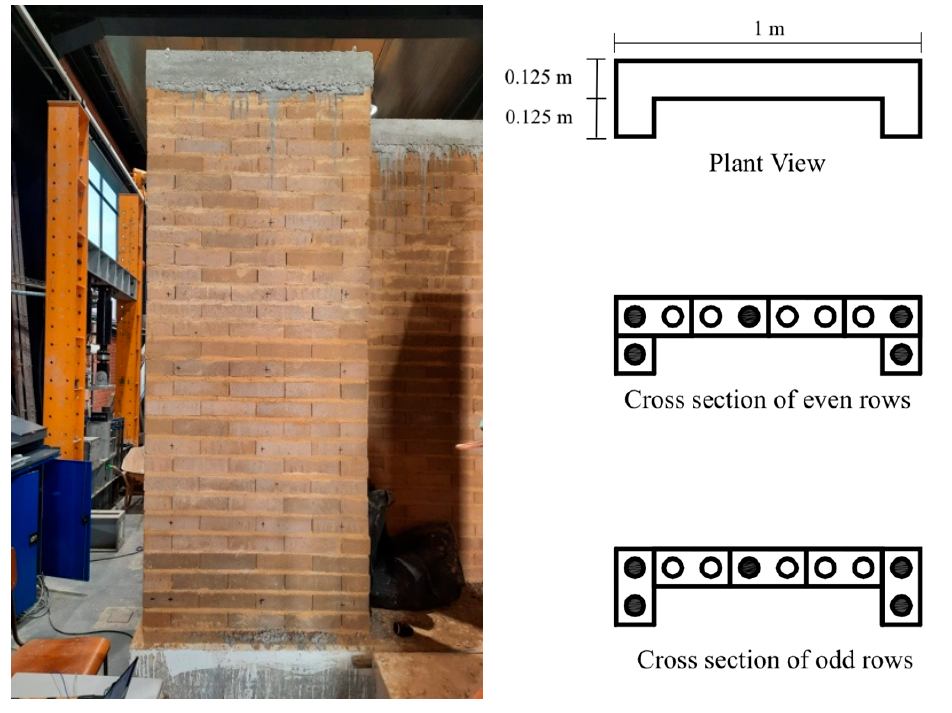
Figure 2. Masonry wall